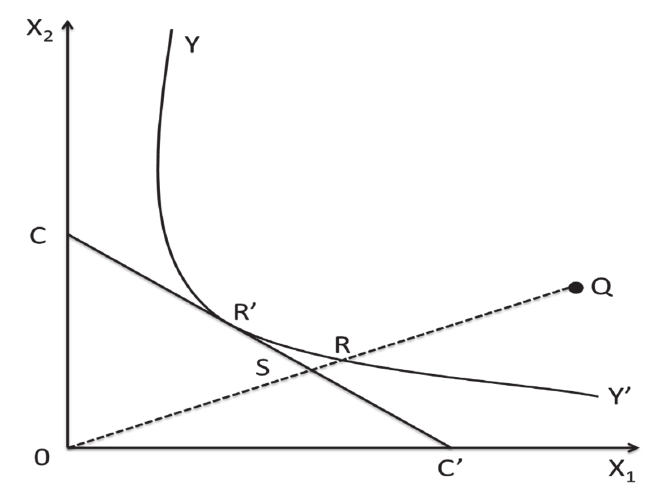
Fig. 1. Technical and Allocative Efficiency